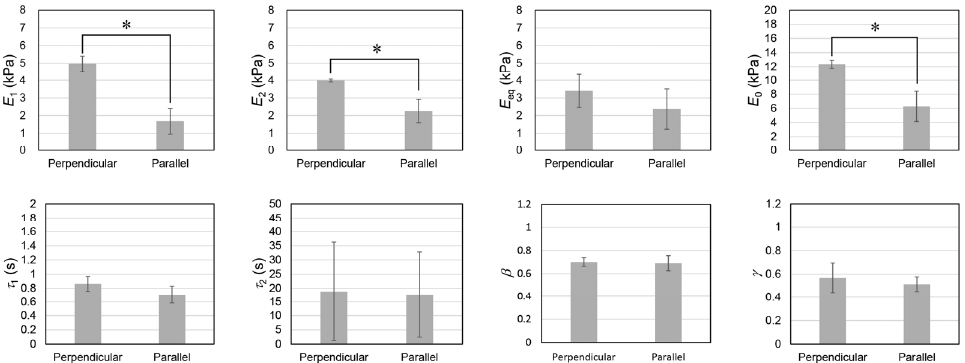
Figure 7. Comparison of the relaxation parameters between the perpendicular direction and the parallel direction. Error bars indicate standard deviation ( n = 3). Asterisks indicate significant differences of p < 0.05. The comparisons were performed by using Student’s t